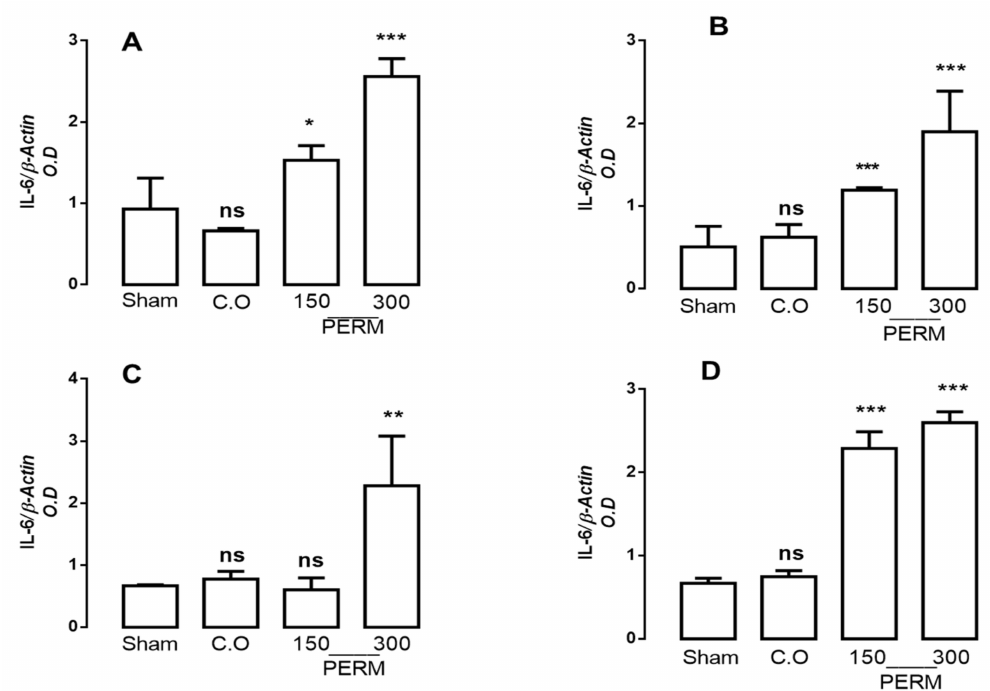
Figure 3. mRNA expression for IL-6 in the cerebellum ( A ), cerebral cortex ( B ), cerebral hemispheres ( C ) and medulla ( D ) in rats treated with corn oil (control group), permethrin 150 mg/kg or 300 mg/kg and rats without treatment (sham group). Values are mean ± SD ( n = 4 for each group). The results were analyzed with ANOVAs followed by Bonferroni’s multiple comparisons tests to compare permethrin (150 or 300 mg/kg) groups versus the control group (sham). Data from 6 independent experiments run in quadruplicate. Without statistically different is showed as ns. * p < 0.05 vs. sham group,